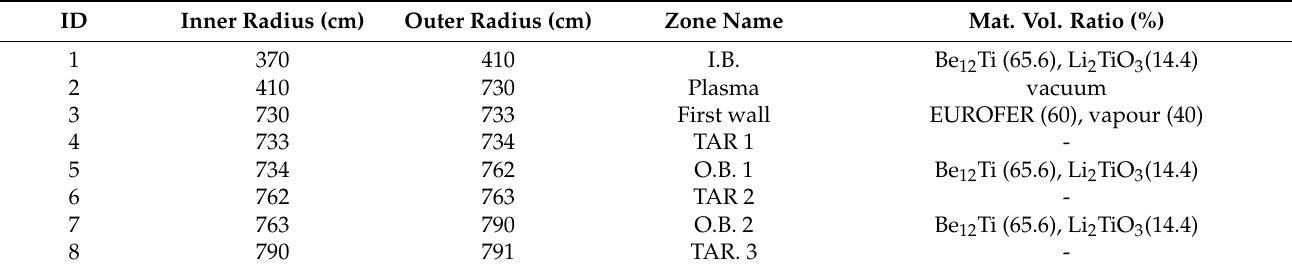
Table 8. Radial dimensions and material